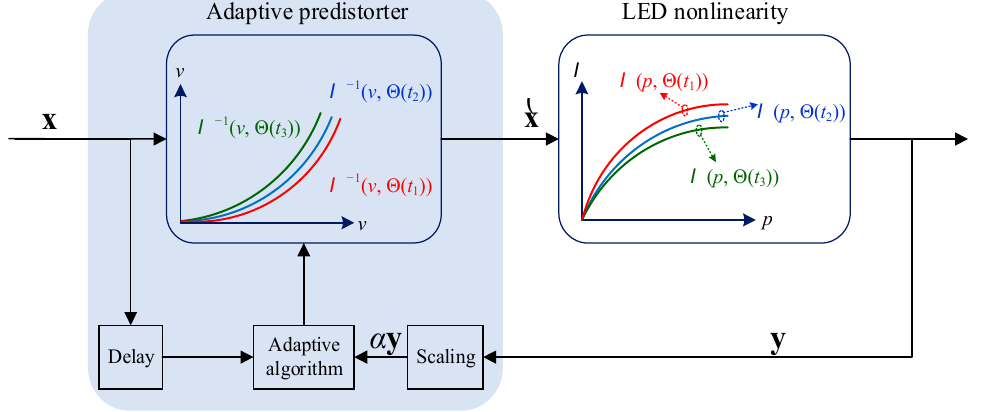
Figure 1. Illustration of the application of an adaptive predistorter to compensate for LED time-variant nonlinearity.